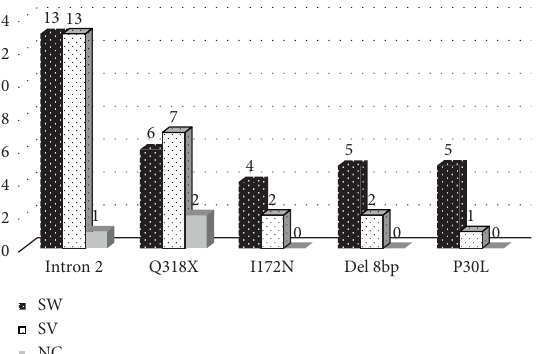
Figure 1: Alleles affected by mutations according to the clinical forms of 21-hydroxylase deficiency in the Cuban Table 1: Genotype-phenotype correlation in Cuban patients with 21-hydroxylase deficiency. Molecular findings